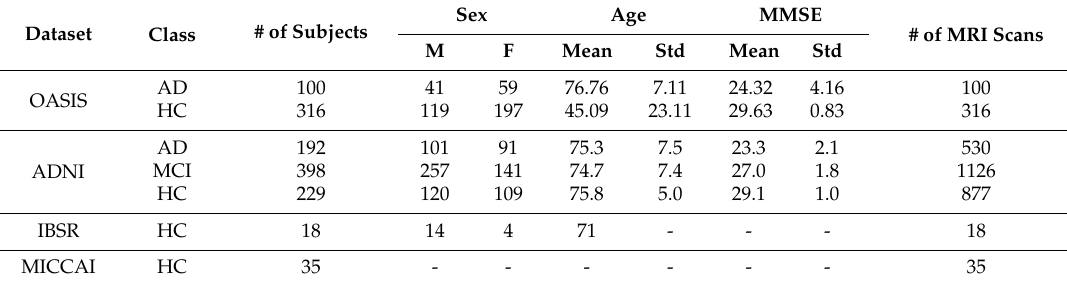
Table 1. Details of the OASIS, ADNI, IBSR, and MICCAI